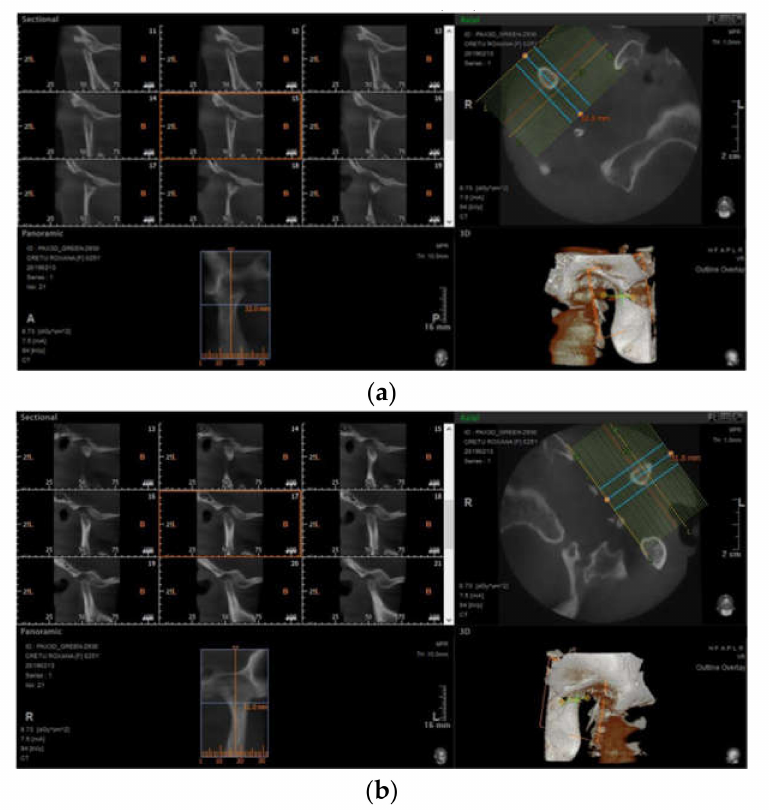
Figure 2. CBCT aspects of the ( a ) right and ( b ) left temporomandibular joint